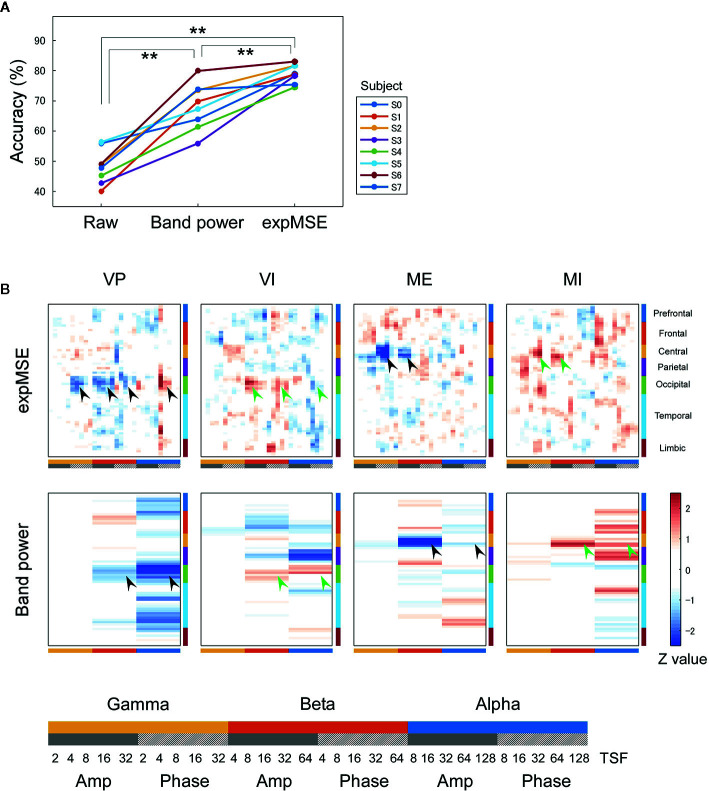
Intra-subject decoding of each task. (A) Decoding accuracies compared among raw data, band power and expMSE. Each color corresponds to a subject; **p < 0.01. (B) Task-related sensitivity maps of the example (subject S4). Upper and lower panels respectively portray maps for the expMSE and band power (VP, visual perception; VI, visual imagery; ME, motor execution; MI, motor imagery; black arrow, modality-specific sensitivity; green arrow, inverted sensitivity in the modality-specific regions). At the bottom are details of the horizontal axes: frequency × component (Amp/Phase) × TSF; Amp, amplitude expMSE; Phase, phase expMSE.